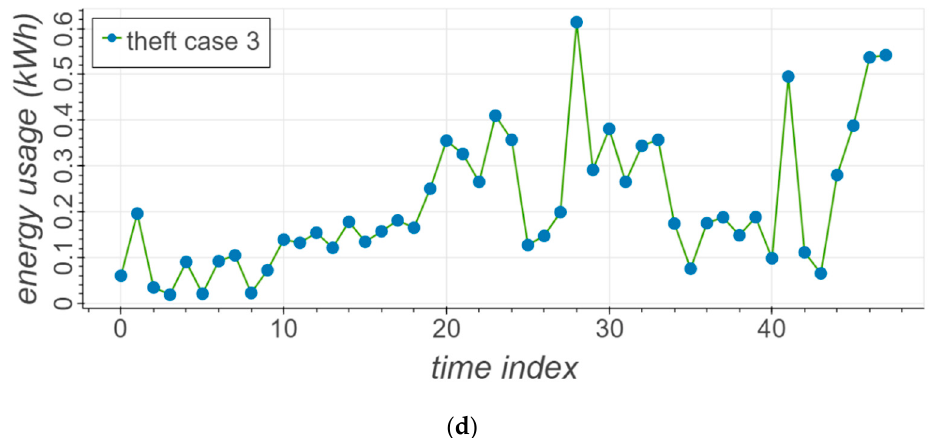
Figure 2. ( a ) Real usage of an example day with the highlighted “theft period window” showing the most probable time period for theft to occur at. ( b ) Theft case 1 generated from the example day. ( c ) Theft case 2 generated from the example day. ( d ) Theft case 3 generated from the example day.